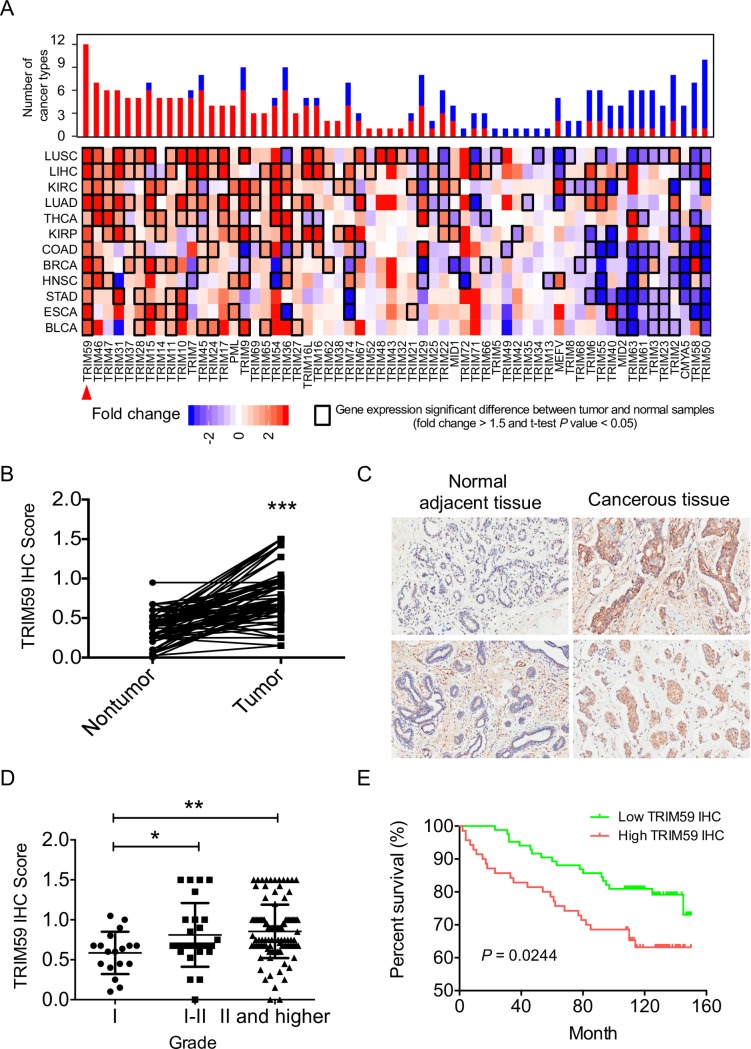
Increased expression of TRIM59 correlates with breast cancer progression and poor survival in patients.(A) The fold change of TRIM family genes across 12 cancer types (y-axis) compared with their paired controls (obtained from adjacent non-tumorigenic tissues) based on TCGA dataset analysis. The color intensity indicates the range of fold change, and black boxes indicate a significant difference in gene expression between tumor and adjacent non-tumorigenic tissues (fold change > 1.5 and P value < 0.05). Upper bars show the frequency of cancer types, with up-regulation (red) and down-regulation (blue) for each TRIM family gene. Top hit TRIM59 was highlighted by red arrowhead. (B) Quantitative analysis of TRIM59 IHC staining in 87 paired tumor/non-tumor samples. (C) Representative IHC staining images of adjacent normal tissues and breast cancerous tissues probed with the anti-TRIM59 antibody. A total of 154 patient samples were stained and analyzed. (D) Analysis of TRIM59 staining intensity in association with clinical stages of breast tumor samples (Grade I, n = 18; Grade I–II, n = 26; Grade II and higher, n = 110). An IHC score less than or equal to 0.75 was defined as “Low IHC ratio” or Down-regulation/No change and a value greater than 0.75 was defined as “High IHC ratio” or Up-regulation. (E) Kaplan–Meier survival curves for breast cancer patients based on the scores of TRIM59 IHC staining. High intensity of TRIM59 immunostaining strongly associates with poor patient survival, P = 0.0244. Data in B and D are presented as means ± SD; *P < 0.05, **P < 0.01, ***P < 0.001. The underlying data can be found in S1 Data. BLCA, urothelial bladder cancer; BRCA, breast invasive carcinoma; COAD, colon adenocarcinoma; ESCA, esophageal carcinoma; HNSC, heck and neck squamous cell carcinoma; IHC, immunohistochemistry; KIRC, kidney renal clear cell carcinoma; KIRP, kidney renal papillary cell carcinoma; LIHC, liver hepatocellular carcinoma; LUAD, lung adenocarcinoma; LUSC, lung squamous cell carcinoma; STAD, stomach adenocarcinoma; TCGA, the Cancer Genome Atlas; THCA, thyroid carcinoma; TRIM, tripartite motif.